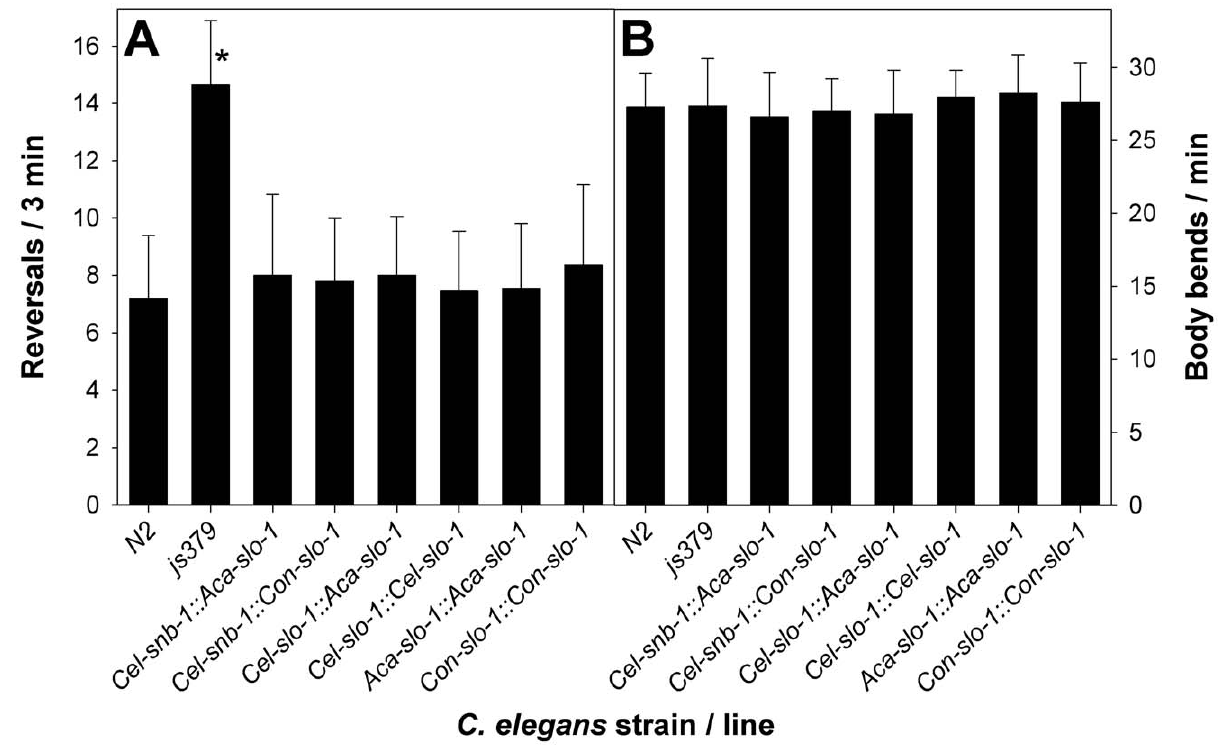
Figure 2. Behavioural phenotype of transgenic C.elegans . (A) number of reversals in 3 min were counted on NGM agar without bacteria for N2 Bristol, slo-1(js379) and the indicated transgenic lines derived from slo-1(js379) . All values are means + SD. An asterisk (*) marks significant differences to all other lines (p , 0.001) determined by One-Way-ANOVA followed by Tukey’s test. (B) number of body bends per minute counted on NGM agar without bacteria. One-Way-ANOVA revealed no significant differences between different lines. N2, N2 Bristol wild-type strain; js379 , slo-1(js379) mutant strain; Cel-snb-1::Aca-slo-1 , line expressing A. caninum slo-1 from the C. elegans snb-1 promoter; Cel-snb-1::Con-slo-1 , line expressing C. oncophora slo-1 from the C. elegans snb-1 promoter; Cel-slo-1::Aca-slo-1 , line expressing A. caninum slo-1 from the C. elegans slo-1 promoter; Cel-slo- 1::Cel-slo-1 , line expressing C. elegans slo-1 from the C. elegans slo-1 promoter; Aca-slo-1::Aca-slo-1 , line expressing A. caninum slo-1 from the A. caninum slo-1 promoter; Con-slo-1::Con-slo-1 , line expressing C. oncophora slo-1 under control of the C. oncophora slo-1 promoter.